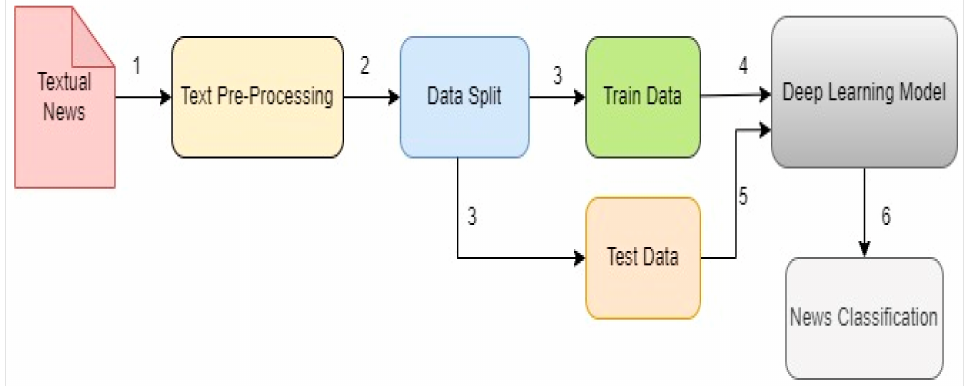
Figure 2. DL in news